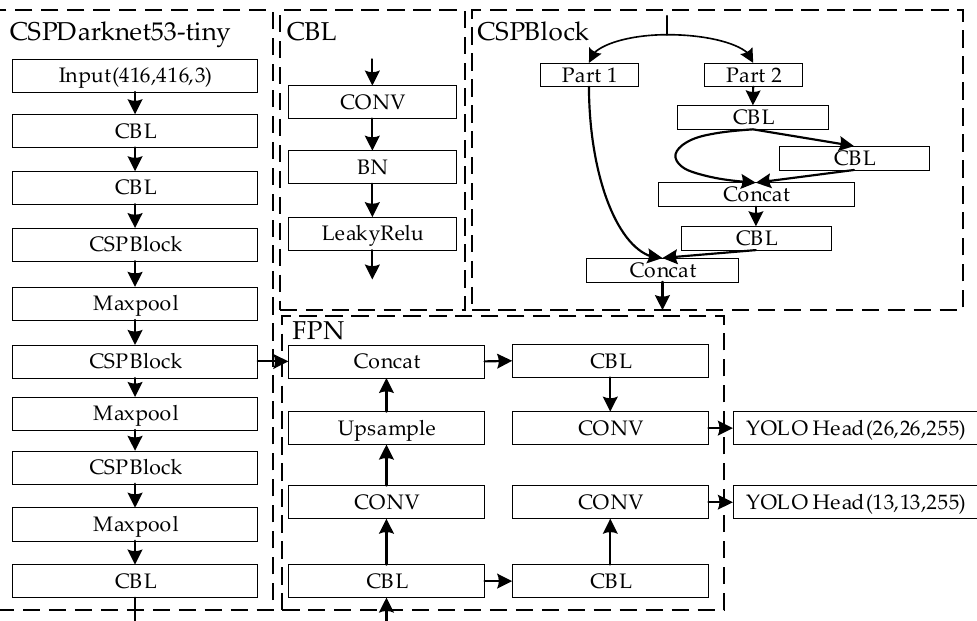
Figure 4. The network structure of YOLOv4-tiny.